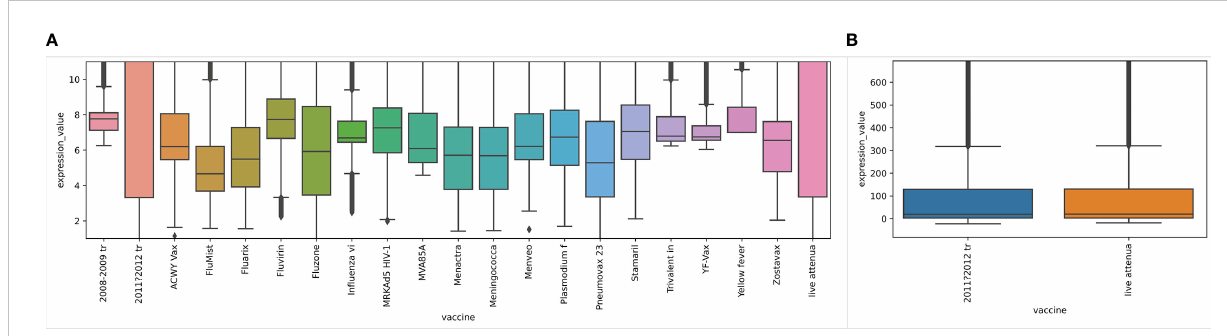
FIGURE 5 Boxplot of expression values of individual vaccines. (A) Zoomed-in view of the boxplot for all vaccines in the dataset. (B) Zoomed-in view for two vaccines having much wider